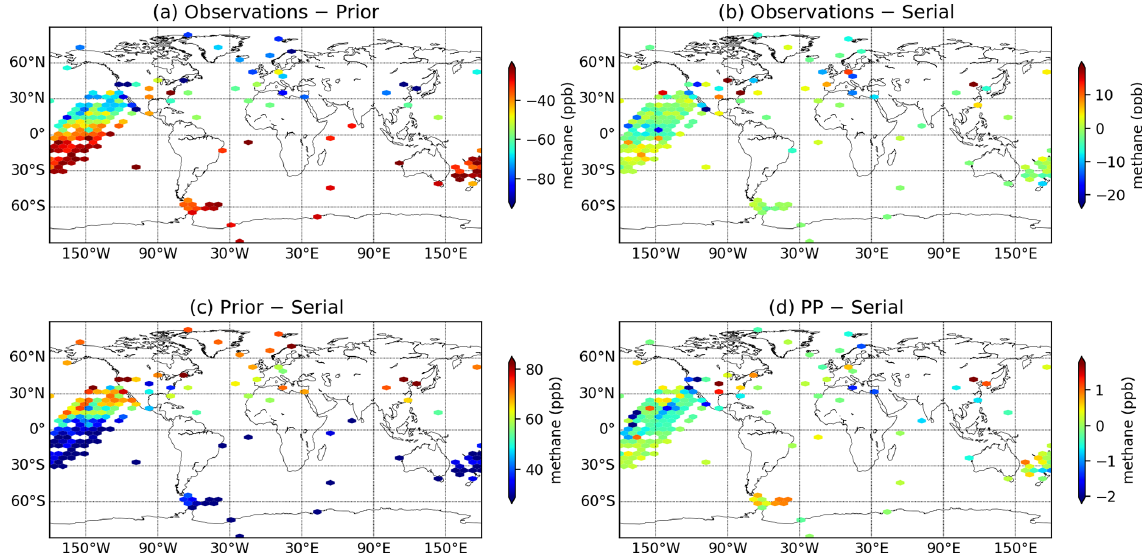
Figure 4. Methane mole-fraction differences at the observation sites (see Fig. 2b). Panels (a) , (b) , (c) , and (d) show the average difference between observations and prior, observation and serial, prior and serial, and PP and serial, respectively. The color scale range is set at mean ± 1 standard deviation of the plotted